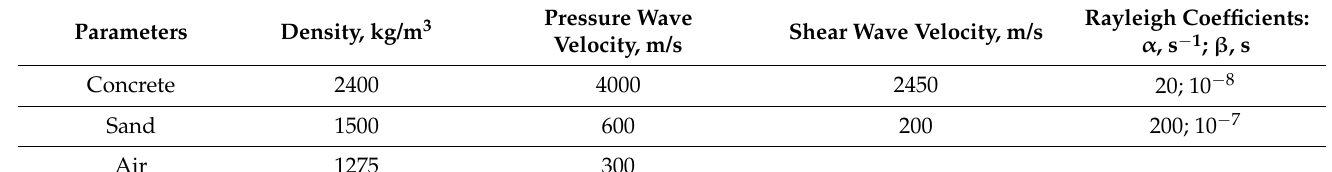
Table 1. The properties of simulated